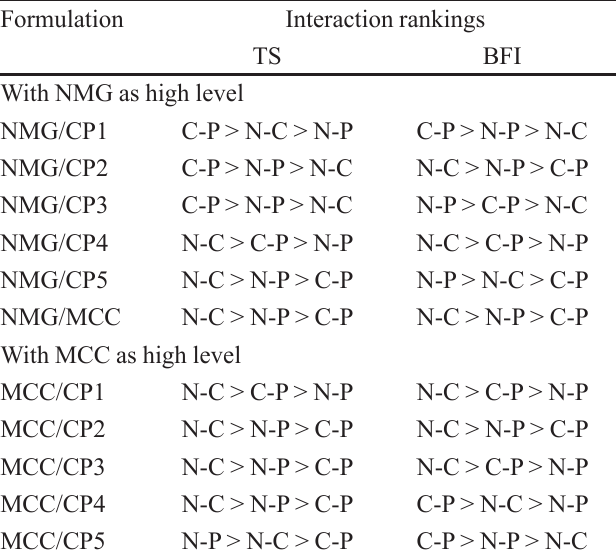
TABLE VI - Rankings obtained for the interaction variables on the TS and BFI of tablets Formulation Interaction rankings